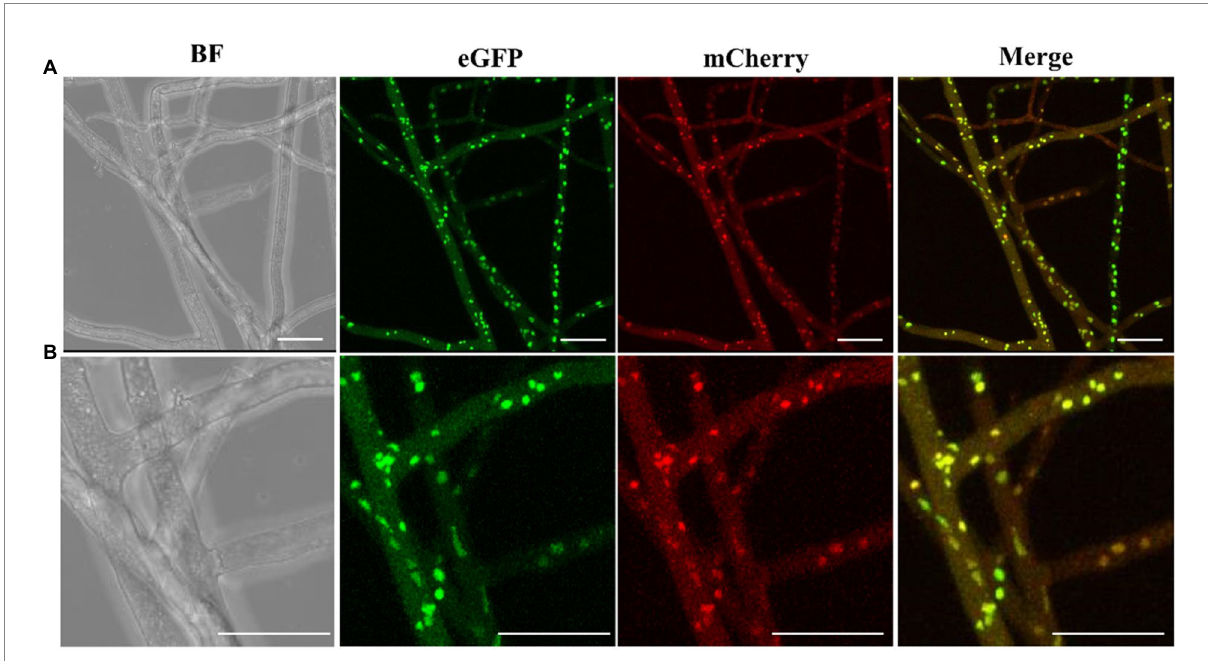
FIGURE 6 Fluorescence microscopic observation of nucleus confirms heterokaryon formation. (A) eGFP or mCherry fluorescence signals of M. importuna hyphae at day 5 post culture in the CYM medium supplemented with 10 μ g/ml hygromycin. eGFP exhibited a stronger signal intensity than mCherry. The overlapping of red and green signals occupied most area. (B) The enlarged images of (A) , the yellow fluorescence signal represents the overlapping of red and green signals. BF, bright field. Scale bars = 25 μ m.